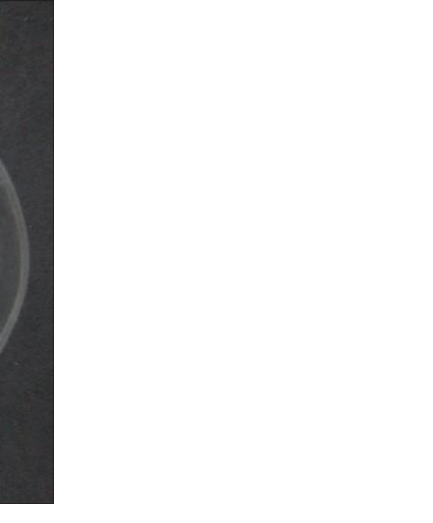
Fig 5. Modified Hodge test for carbapenamase